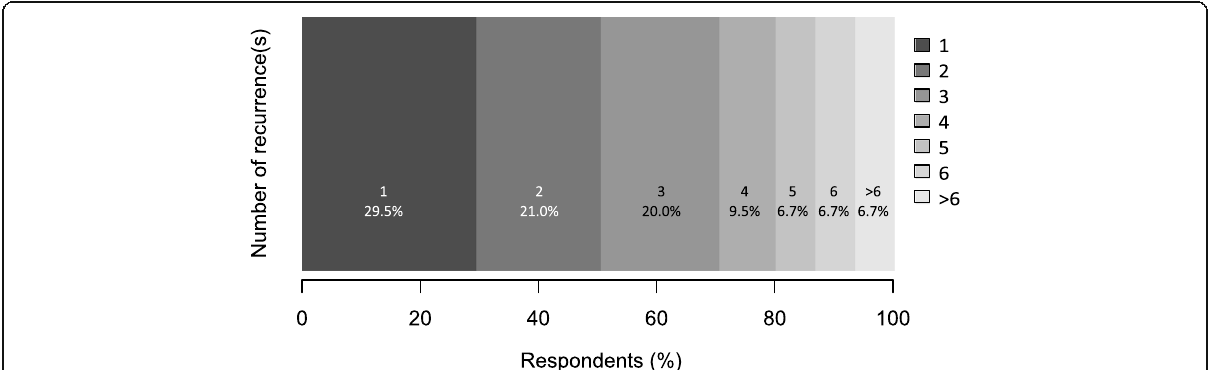
Fig. 2 Number of recurrences reported by subjects with at least one recurrence in Past CDI group